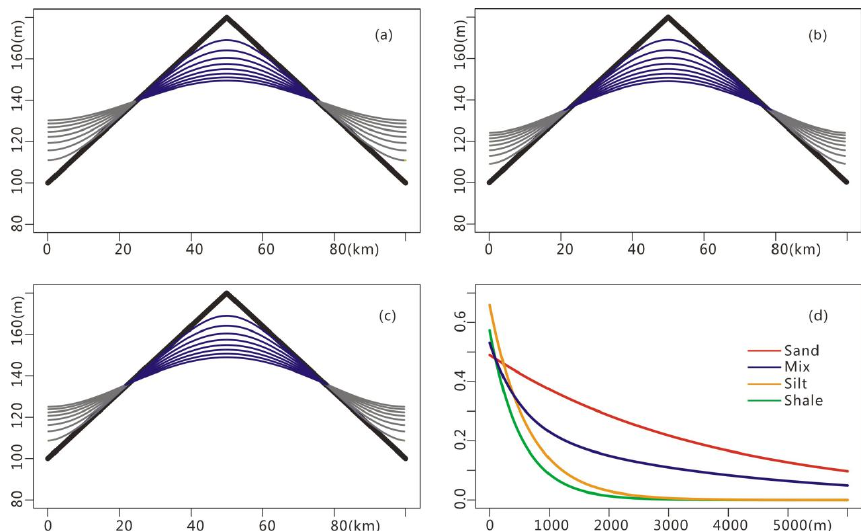
Figure 3. Customized compaction and the porosity curves: (a) the x – z plot with the original depth–porosity scale, (b) the x – z plot with a magnified depth–porosity scale ( × 100) to enhance compaction, (c) the x – z plot with a magnified depth–porosity scale ( × 1000) to enhance compaction, (d) depth–porosity curves used in the compaction module (the mix indicates mixed 50%–50% sand and shale; for details, see Athy, 1930; Sclater and Christie,